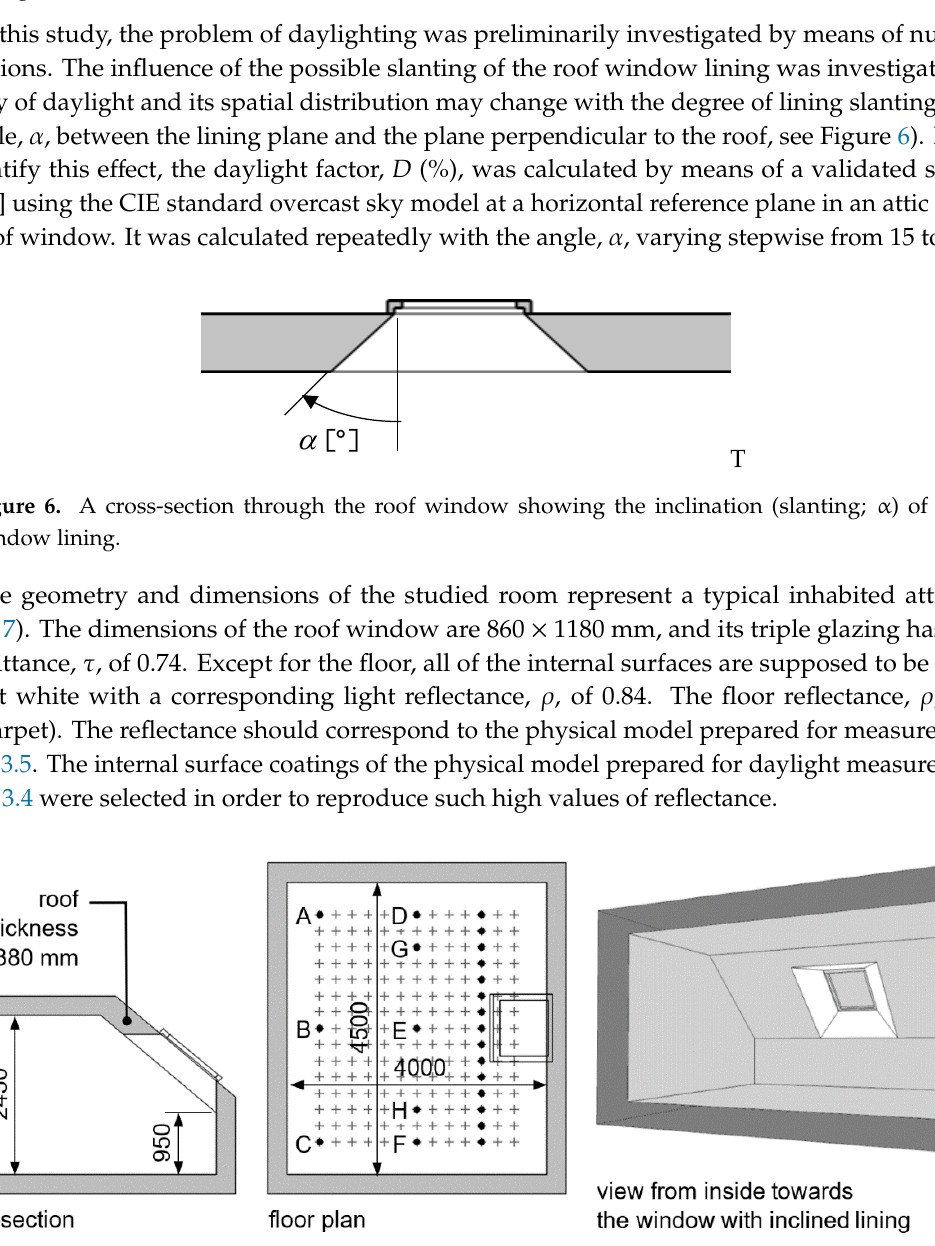
Figure 7. The geometry of the room studied for daylighting distribution (letters represent the control points for investigation). (Unit: